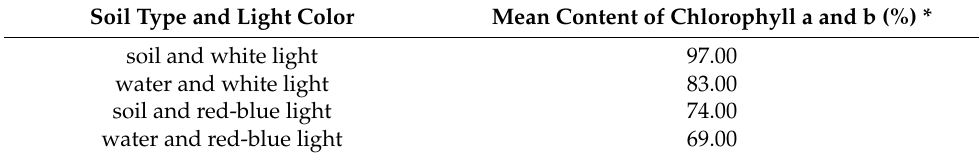
Table 5. Summary of statistical analysis of relationships between chlorophyll fluorescence, (Fv/Fm) light supplementary light treatments (white vs. red-blue), and growth regulator treatments (NAA, GA 3 and IAA). NIR’s multiple comparison test and ANOVA (Fisher’s test). * p —probability value. * Significant differences ( α = 0.05), values greater than the selected significance level are not important.